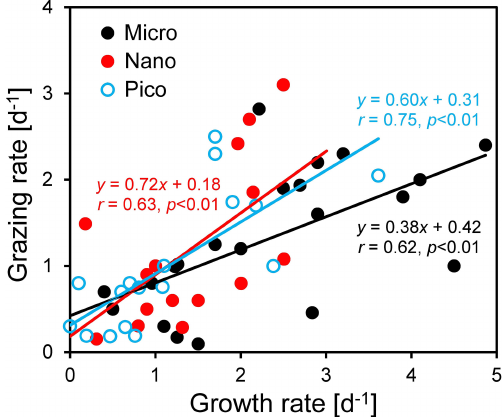
Figure 7. Regressions between natural phytoplankton growth rate and microzooplankton grazing rate for micro-, nano-, and pico-cells in the coastal northern South China Sea outside the Pearl River es- tuary. Note that negative rates have been excluded from the regres-